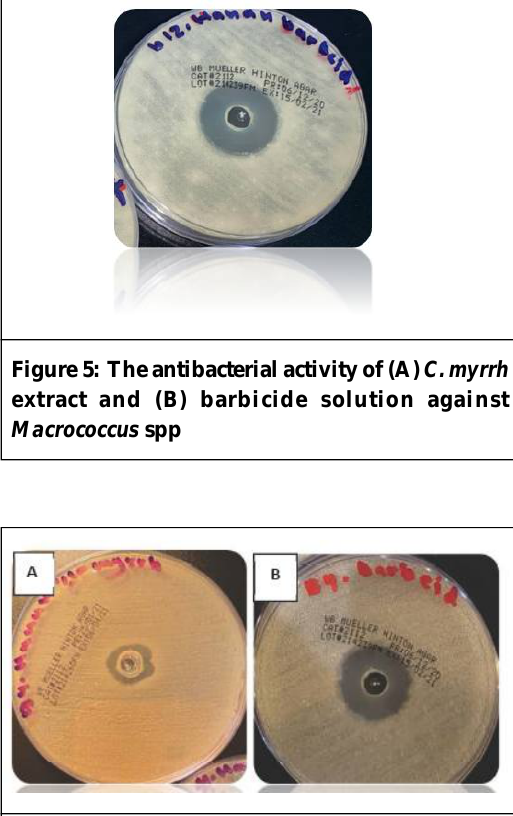
Figure 8: The antibacterial activity of(A) C. myrrh extract and (B) barbicide solution against Microbacterium spp